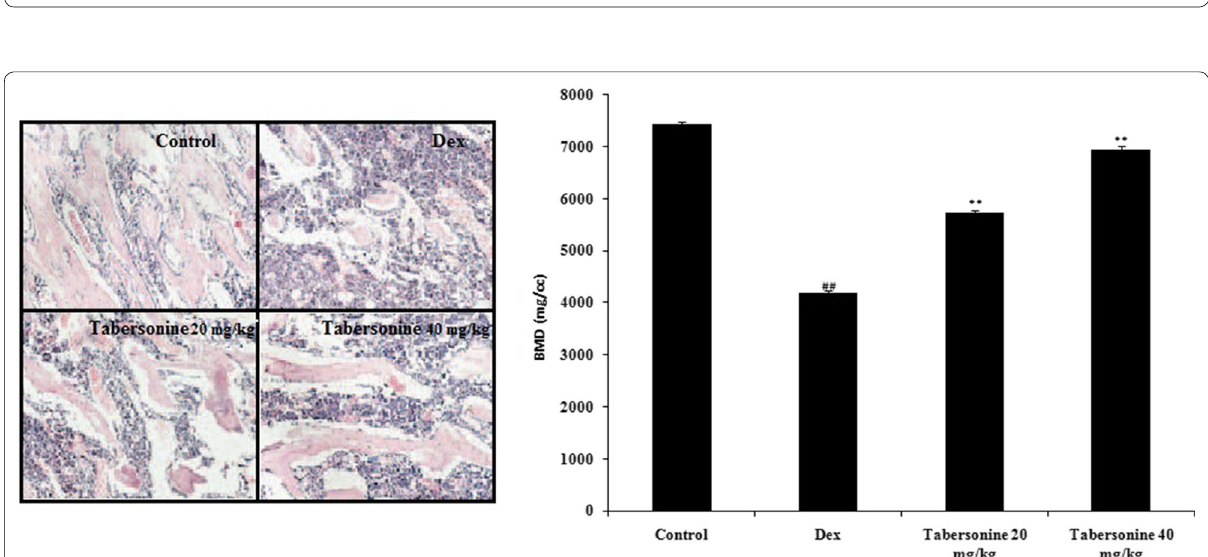
Fig. 8 Effects of tabersonine on the levels of caspase-3, Bcl-2, Bax and cytochrome- C in osteoblasts. Means ** p < 0.01 vs. Dex group